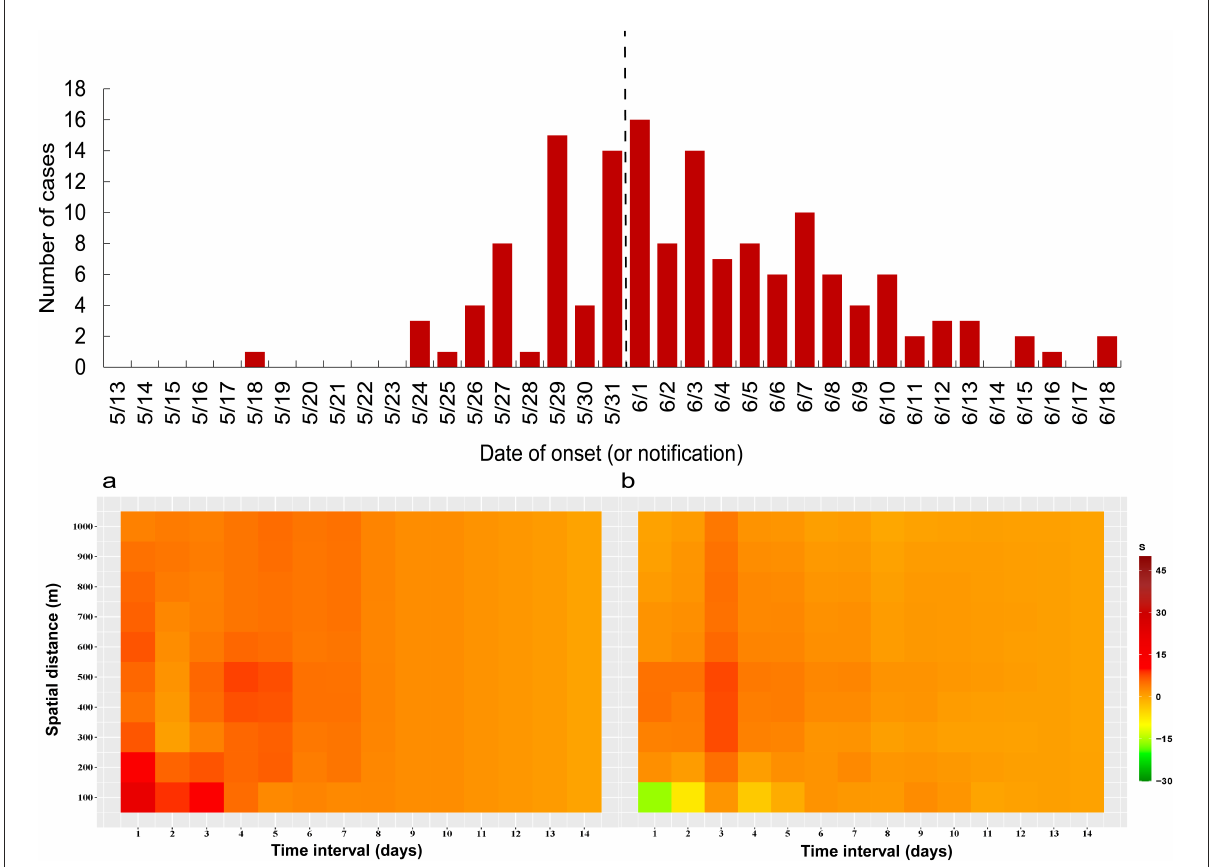
FIGURE5 Spatial-temporal clustering of all cases before and after taking interventions (1,000m), (a) May 18 to May 31, 2021, (b) June 1 to June 18, 2021.